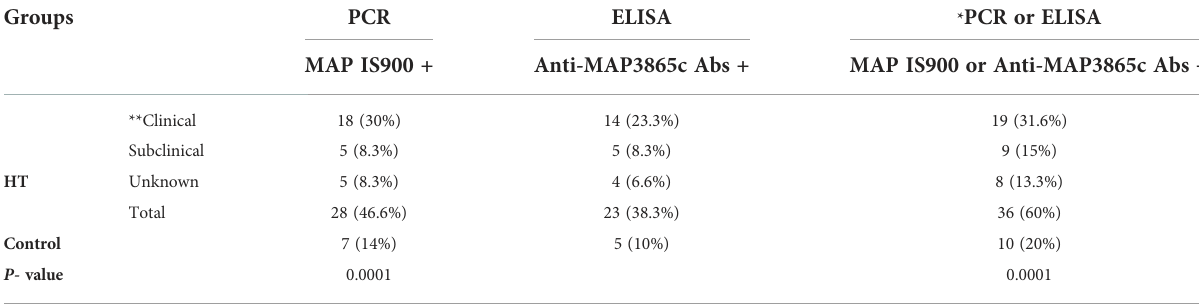
TABLE 3 Nested-PCR results of MAP IS900 and ELISA results for MAP3865c 125-133 in HT patients and controls.